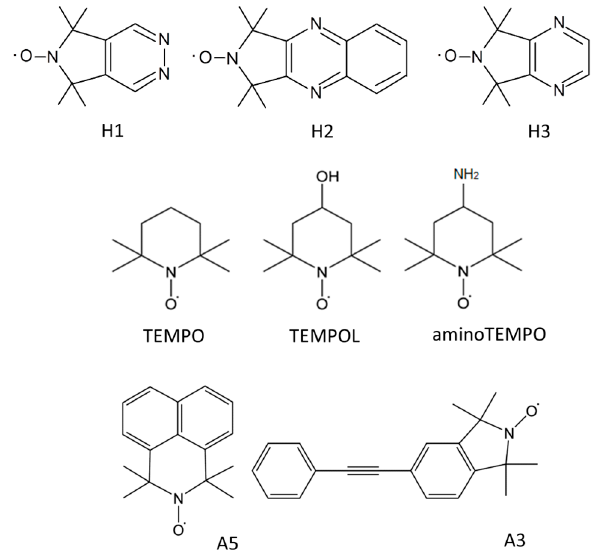
Figure 1. Structures of the novel spin probes and the probes used for studying GOMs earlier [10]. Graphite oxide powder was purchased from ACS (CAS No.: 7782-42-5). The mate-